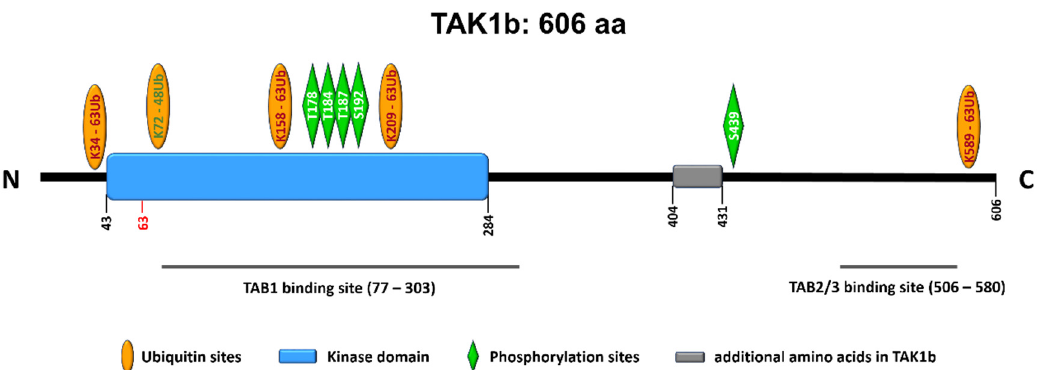
Figure 2. Linear sequence of TAK1b (606 amino acids). The second major splice variant, TAK1a, lacks the 27 amino acids between position 404 and 431. Important posttranslational modifications are indicated.